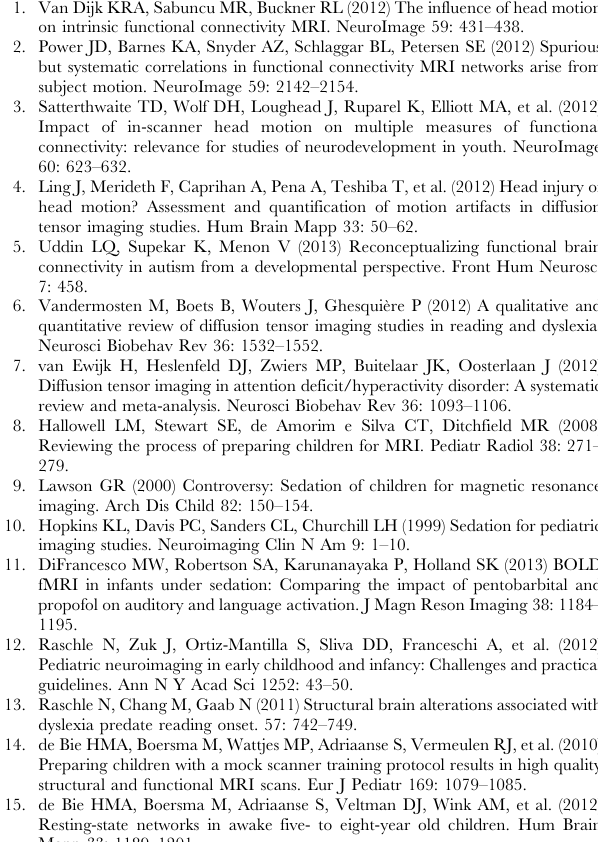
Table S2 Translational (in mm) and rotational (in degrees) DTI motion summaries (mean and standard